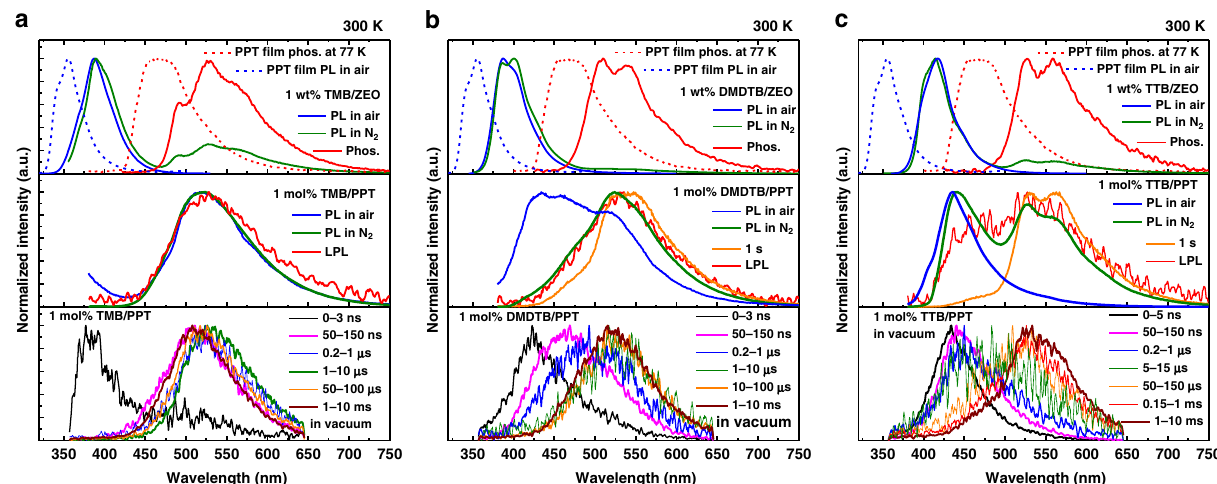
Fig. 3 Study-state and time-resolved emission spectra of the OLPL systems. a Fluorescence and phosphorescence spectra (top), steady-state photoluminescence (PL), and LPL spectra (middle), and time-resolved emission spectra (bottom) of TMB/PPT. b DMDTB/PPT. c TTB/PPT. Optical properties of TMB, DMDTB, and TTB were obtained in ZEONOR fi lms at 300 K. Fluorescence and phosphorescence spectra of PPT were obtained from a neat thin fi lm at 300 K and 77 K, respectively. Time-resolved emission spectra were obtained from streak images at 300 K.